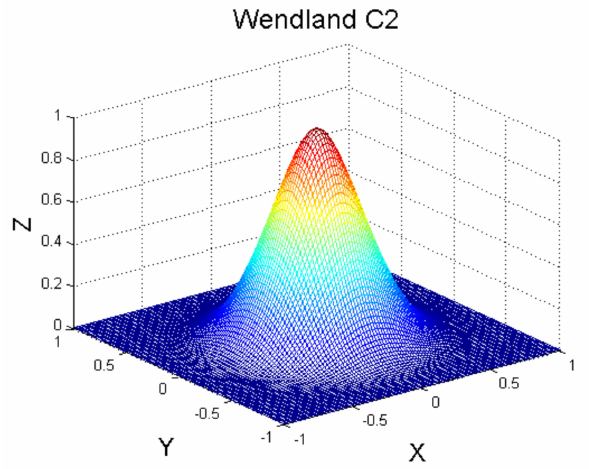
Figure 1. Wendland ψ 3,1 basis